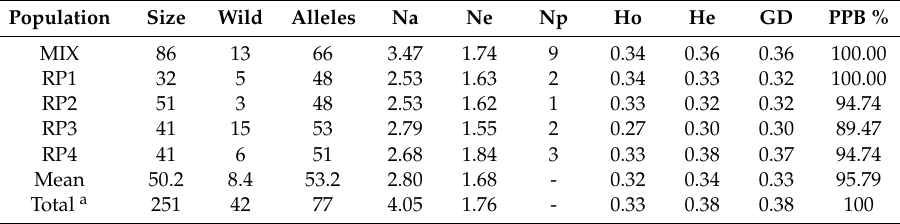
Figure 2. Details of hierarchal structure analysis on 251 Dalbergia odorifera individuals. RP1, RP2, RP3, RP4, and MIX: population code; * : core collection member; Arabic numerals: ID for each individual, see Table S1. Table 2. Summary on genetic diversity statistics of Dalbergia odorifera populations.